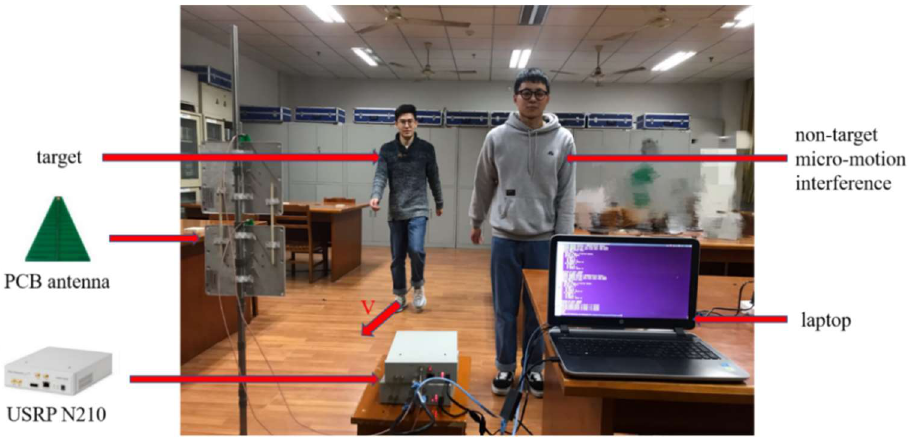
Figure 8. Experimental scene and settings.